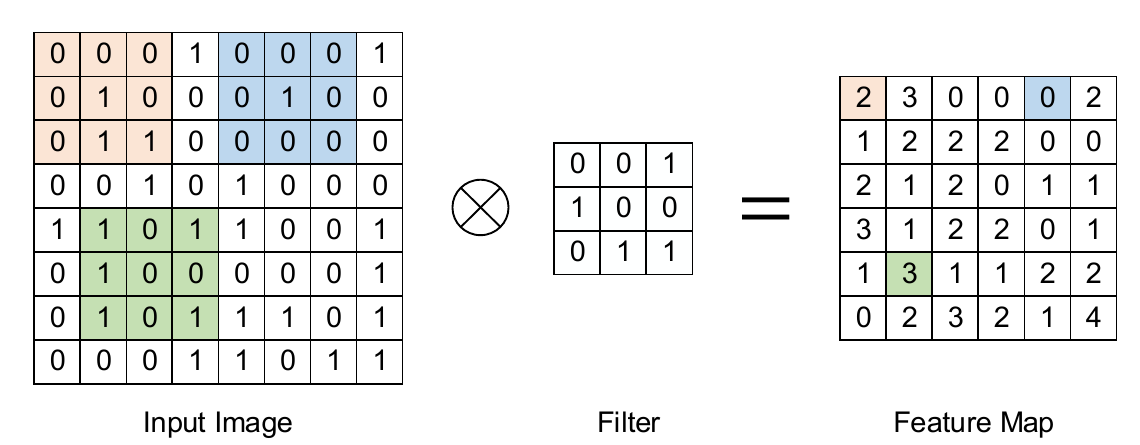
kernel will first operate on the orange area in the upper left corner of the original image (the orange area is also a 3 × 3 square matrix, the same as the kernel) to calculate the Hadamard product of these two matrices. as the original image, padding should be added on the periphery of the original image so that the output feature map and the original image before padding is added share the same size.